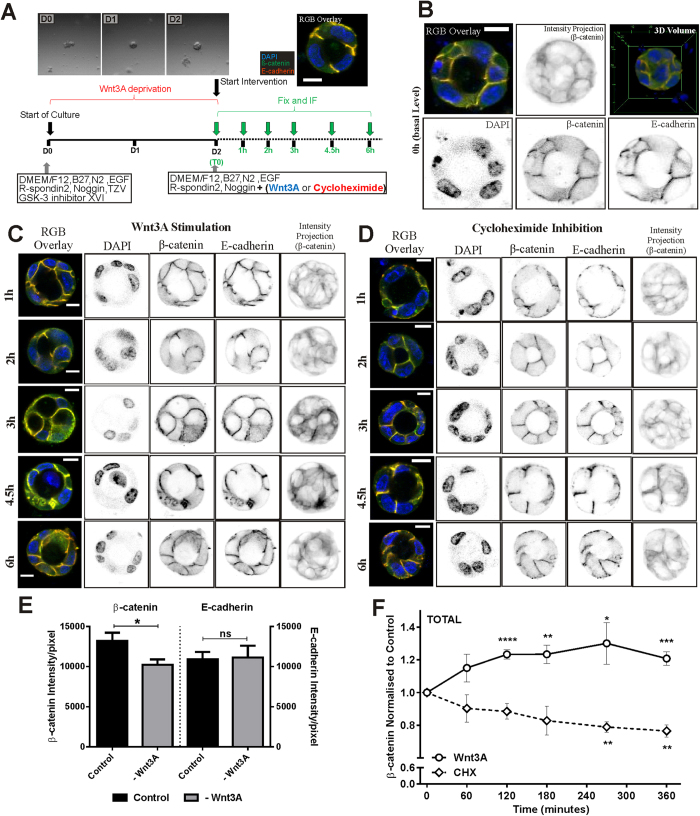
Quantitative analyses of total β-cat and E-cad dynamics in colonospheres.(A) Schematic of colonosphere perturbation experiment. A combination of GSK3β inhibitor XVI and TZV were added at day 0 with the standard medium without Wnt3A. Recombinant Wnt3A or CHX was added from day 2 for pre-defined durations, fixed and stained for β-cat and E-cad before imaging under the confocal microscope. (B) Base levels of β-cat and E-cad in a typical Day 2 colonosphere. Selected colonosphere are shown as RGB overlays of 2D images, intensity projection of 3D β-cat signal, 3D reconstruction and 2D sections of DAPI, β-cat and E-cad. Colonospheres of different duration and under (C) Wnt3A stimulation or (D) CHX inhibition are shown as RGB overlays, 2D sections of DAPI, β-cat and E-cad as well as the intensity projection of 3D β-cat. From the intensity projections, β-cat intensity increased under 3 or 4.5 hours of Wnt3A stimulation while changes were less clear for CHX inhibition. (E) Average total β-cat and E-cad intensity/pixel of positive control (+Wnt3A) and basal levels (-Wnt3A) showing a significant reduction in β-cat at the basal level during two days of Wnt3A deprivation while having no effect on the E-cad levels (*p < 0.05, ±SEM). (F) Relative total β-cat intensity quantitation of colonospheres under Wnt3A stimulation or CHX inhibition for 1,2,3,4.5 or 6 hours were tabulated. β-cat intensity increased significantly under Wnt3A stimulation (n = 5) while under CHX inhibition (n = 3) a gradual decrease in β-cat was observed, significantly after 4.5 hours. (relative to T0: * p < 0.05, ** p < 0.01, *** p < 0.001, **** p < 0.0001, ± SEM). Statistical tests: single-factor anova. Total colonospheres count:296. Scale bars: (B–D) 10 μm.